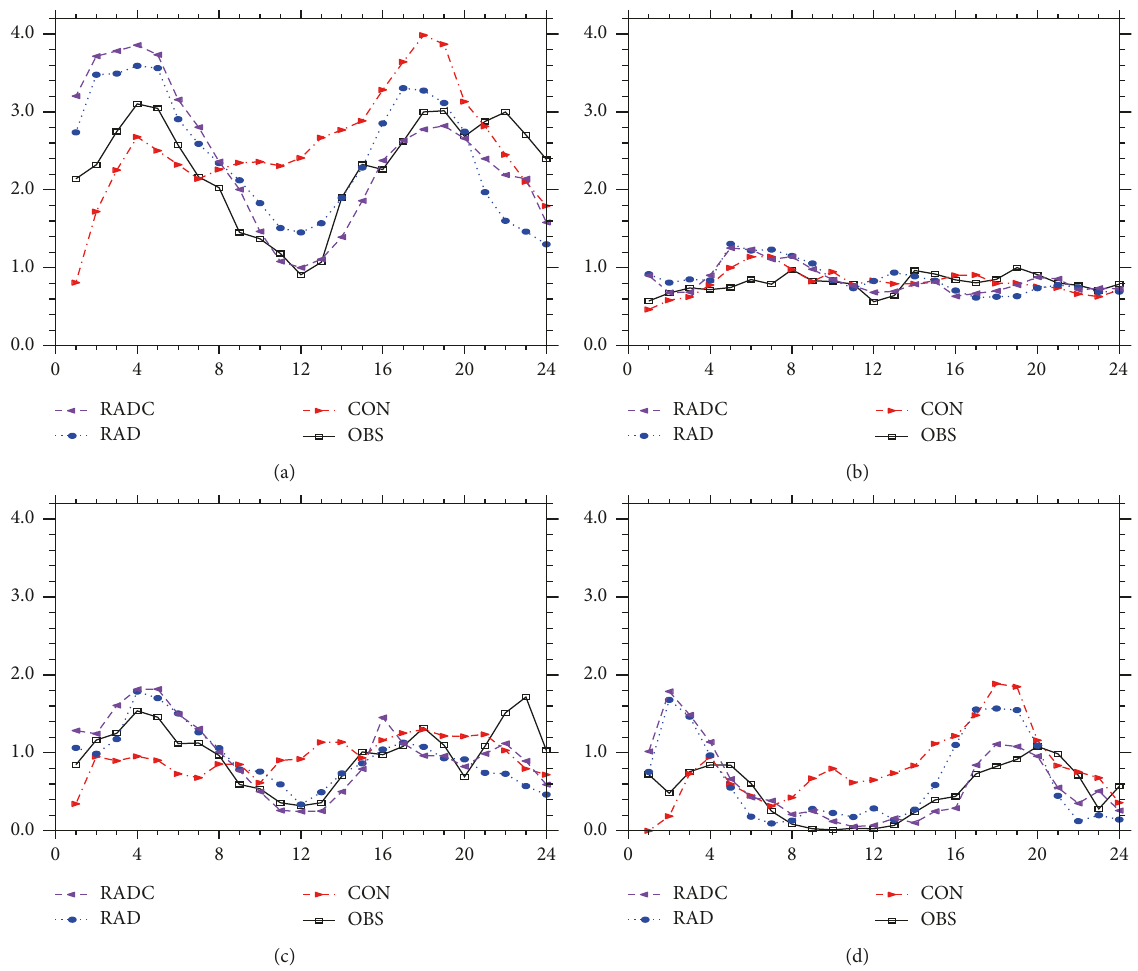
Figure 6: Time series of hourly average precipitation over the key rainstorm area from observations (solid line, black) and simulations of three experiments (dashed lines) (a) (unit: mm/hr). (b), (c), and (d) are the same as (a) but for the rain rates less than 5mm/hr, greater than 5mm/hr and less than 15mm/hr, and greater than 15mm/hr, respectively. The horizontal axis is forecast hours from 0000 UTC 4 July to 0000 UTC 5 July